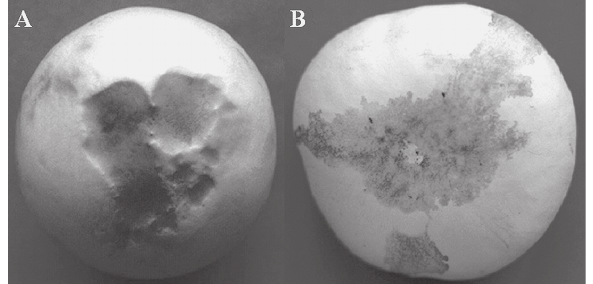
Fig. 3. Symptoms on whole sporophores of Agaricus bis- porus inoculated with 10 ml drops of Pseudomonas agar- ici USB78 (A) or with P. tolaasii NCPPB2192 (B) 10 8 cfu ml -1